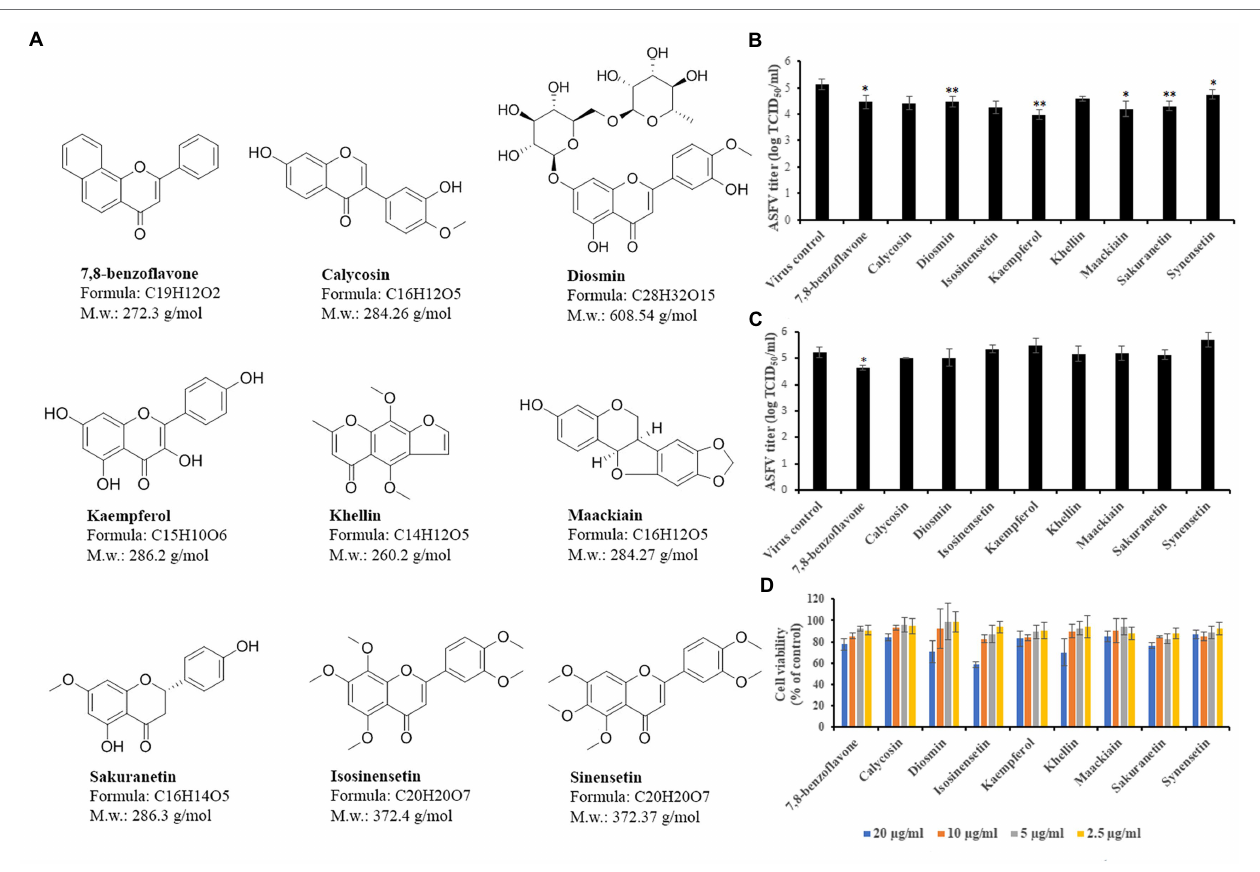
FIGURE 2 | Validation of selected flavonoids. (A) Nine top compounds selected for validation. (B) ASFV titer in Vero cells upon treatment with selected compounds at indicated concentrations. (C) Direct (virucidal) effect of compounds on extracellular ASFV particles. (D) Cytotoxicity of compounds on Vero cells evaluated by crystal violet staining method. Results represent the mean (± SD) of three independent experiments ( n = 3). Significant differences compared to control are denoted by * p < 0.05 and ** p <